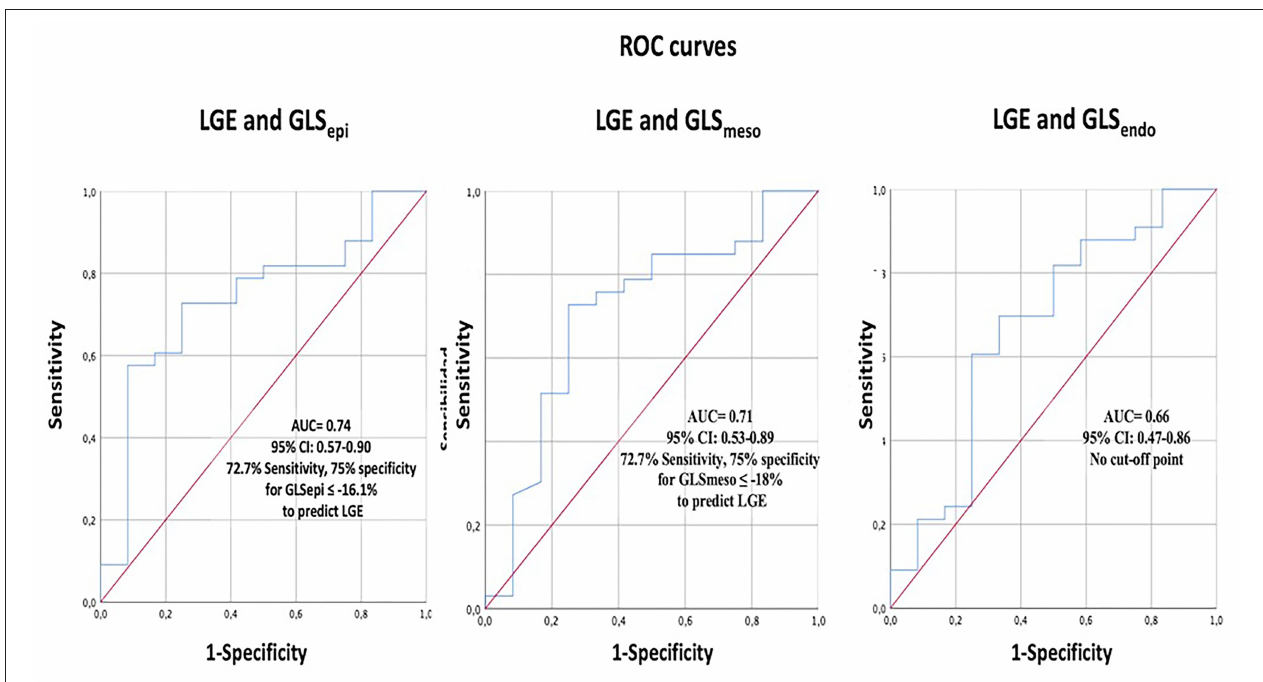
FIGURE 5 | The ROC curve analysis of layer-specific GLS to predict the presence of LGE. GLS, global longitudinal strain; LGE, Late gadolinium enhancement.